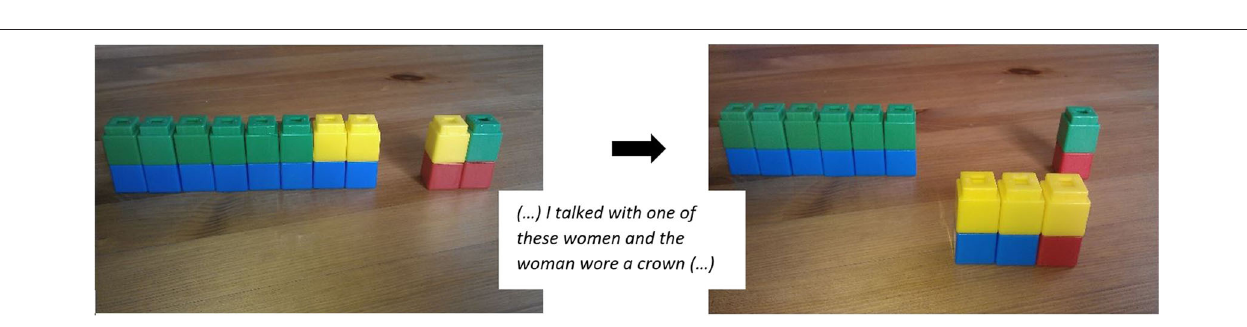
FIGURE 3 | Enactive representation of a typical Bayesian task: Tinker cubes. See Till (2015, p.